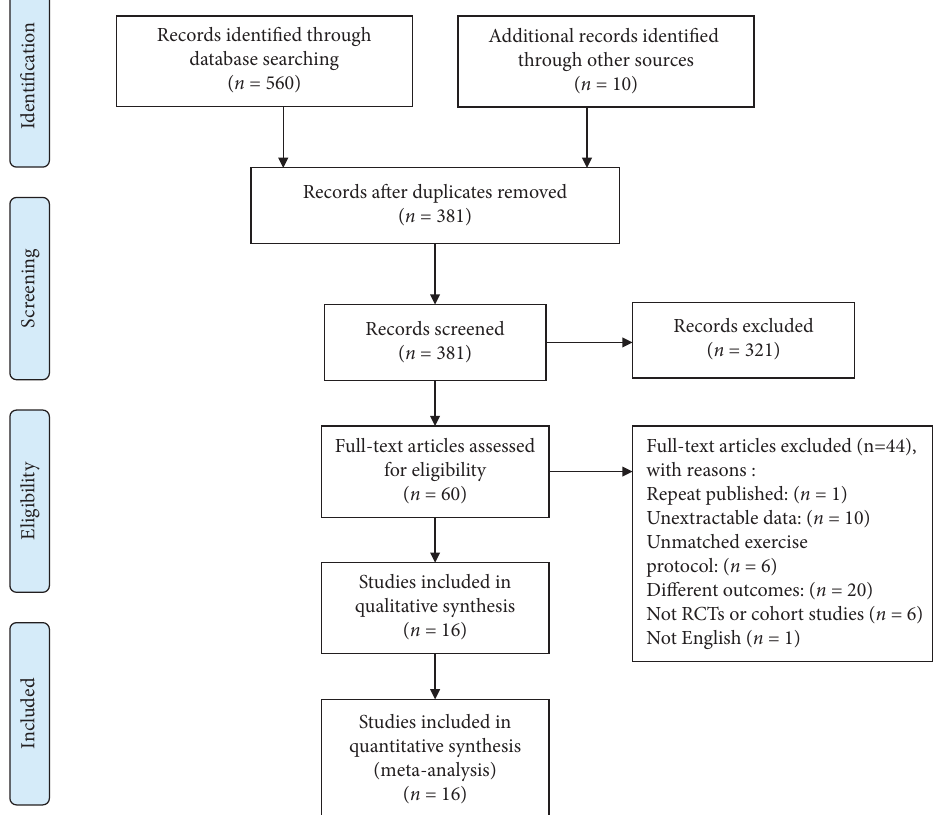
Figure 1: Flowchart of study identifcation and